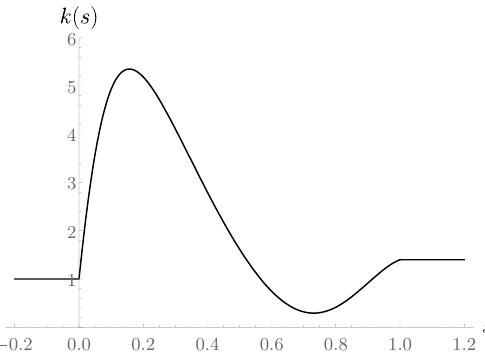
Figure 9: Stiffness profile for the symmetric coupled ESE treating particles distant by d = 0.7 µ m (coupling constant ε = 0.5). Both potentials are controlled by the same protocol which is meant to drive the particles from K time t . The parameters of the ESE plotted here are: t f = 1.4 and Γ = k f